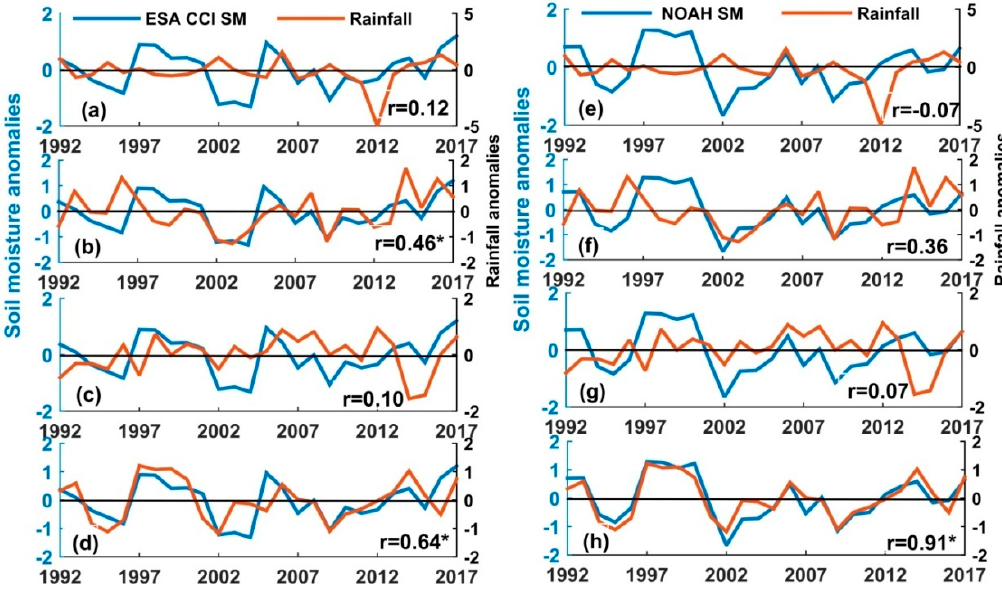
Figure 13. Time series of the autumn soil moisture (ASM) anomalies (estimated using ESA CCI) and rainfall anomalies in the preceding ( a ) winter: December, January, and February (DJF), ( b ) spring: March, April, and May (MAM), ( c ) summer: June, July, and August (JJA), and ( d ) autumn: September, October, and November (SON) averaged over the entire basin. Figure ( e – h ) are the same as Figure ( a – d ), but ASM anomalies were calculated using FLDAS NOAH at 0 to 10 cm depth. The correlation coefficients (r) between two datasets are also shown; the asterisk represents the values significant at p < 0.05.